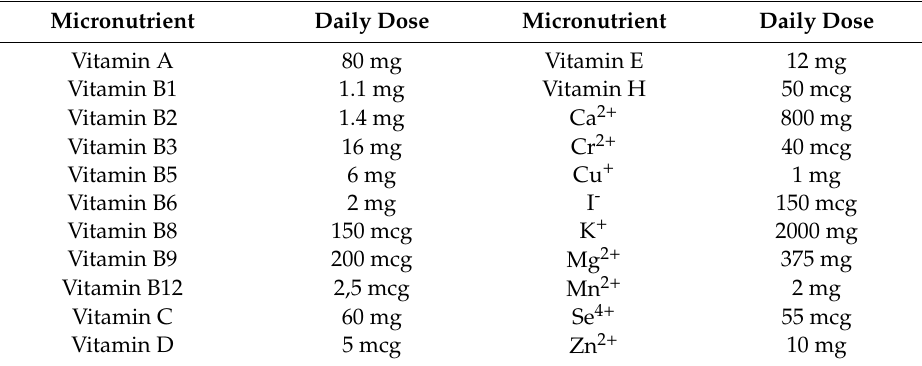
Table 1. Micronutrients daily supplemented through integrators by